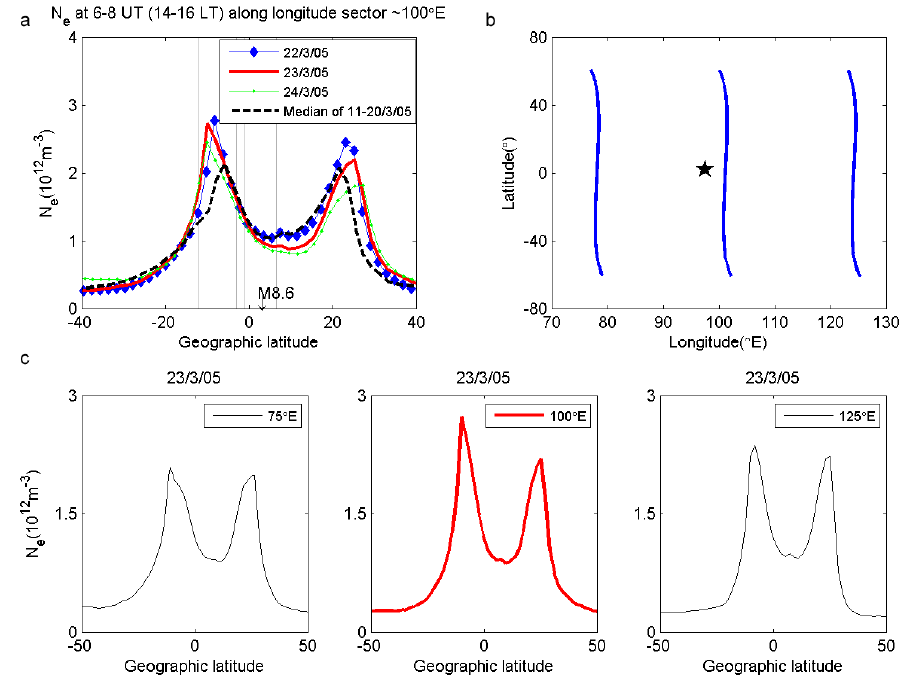
Fig. 8. (a) The CHAMP N e variations observed from 06:00–08:00UT on 22, 23 and 24 March 2005 and the median for 11–20 March along the longitude of about 100 ◦ E. The vertical lines mark the latitude positions of the GPS stations. (b) The geographical projection of the satellite passes and (c) N e measurements along the longitudes of 75 ◦ E, 100 ◦ E and 125 ◦ E on 23 March.